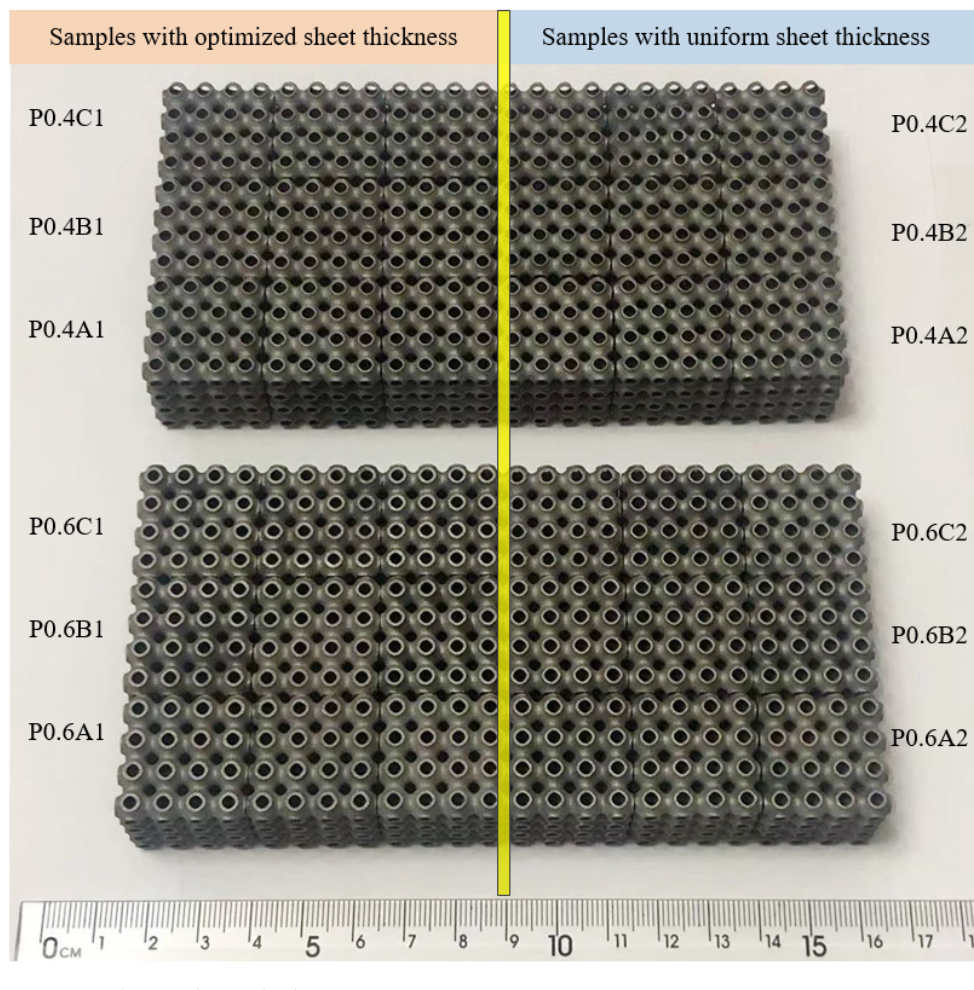
Figure 2. Fabricated samples by SLM.